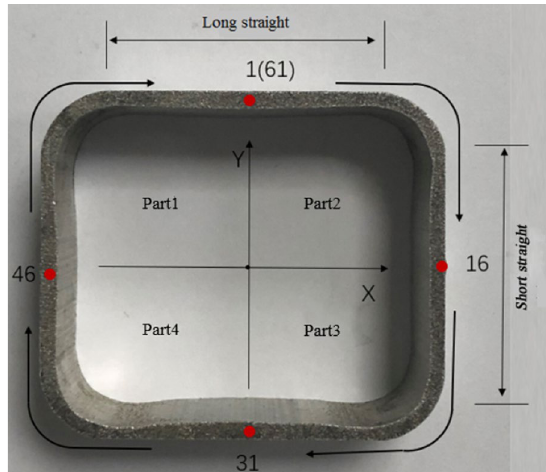
Figure 11 Distribution of the circumferential section of the intermediate